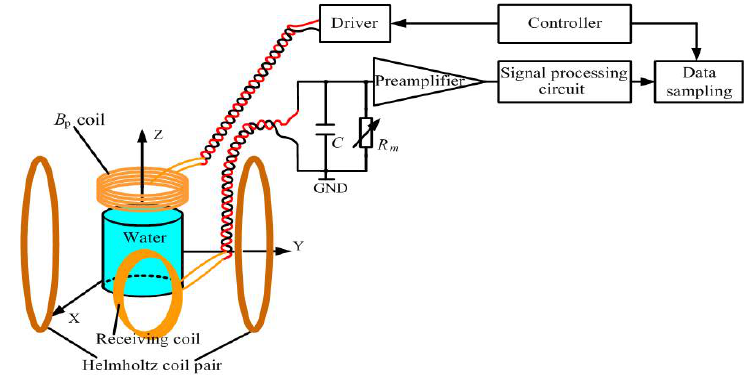
Figure 6. Schematic Diagram of LF-NMR Experimental Model.